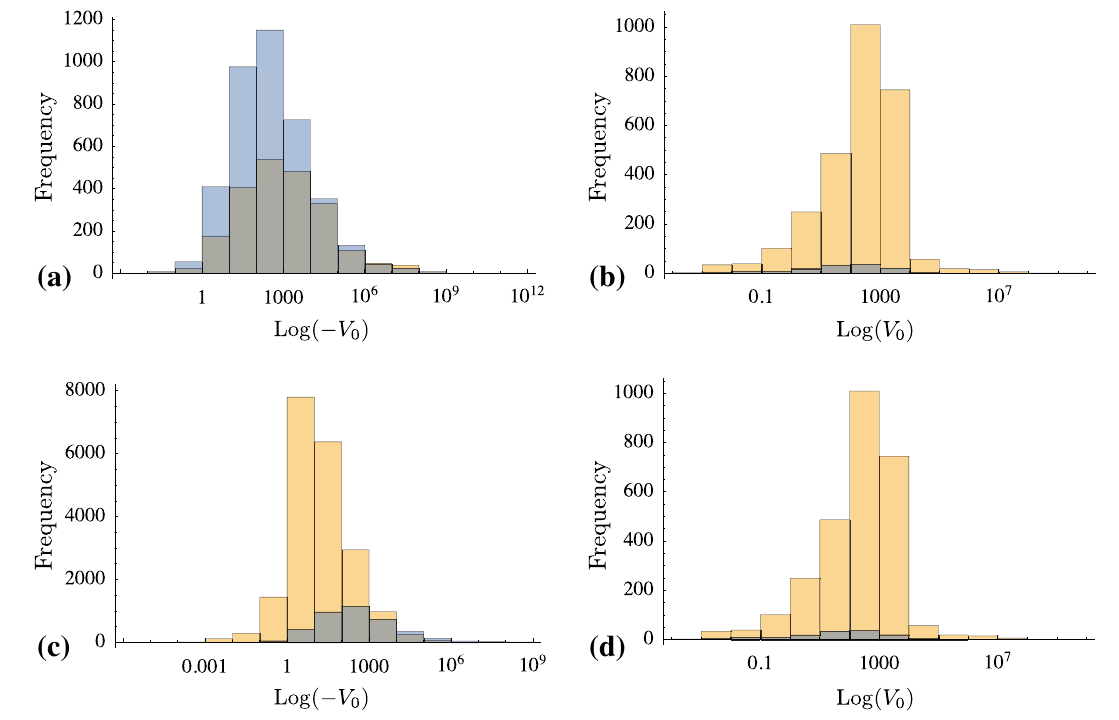
Fig. 4 Histogram of critical points with random fluxes obtained by the ANN + GA (yellow bars) and those randomly found by the GA (blue bars). Intersection appear as grey bars. a AdS vacua, criterion II, b dS vacua, criterion II, c AdS vacua, criterion I, d dS vacua, criterion I. Notice that the a differs from the others in that the amount of solutions